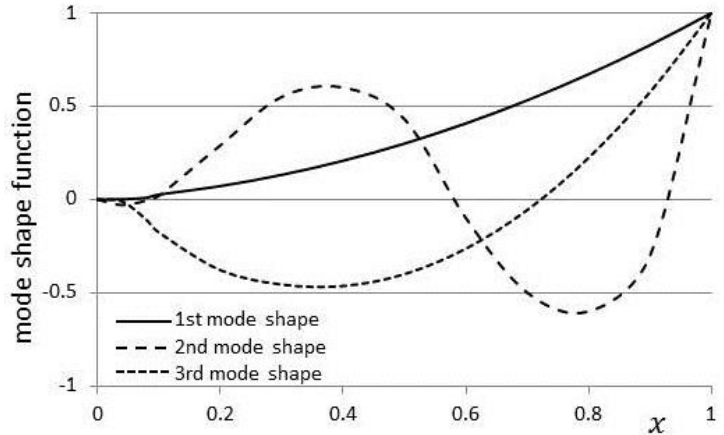
Figure 6. The first three mode shape functions, with θ 0 = 60 ◦ , λ 2 = 1.0 and α = 0.2.